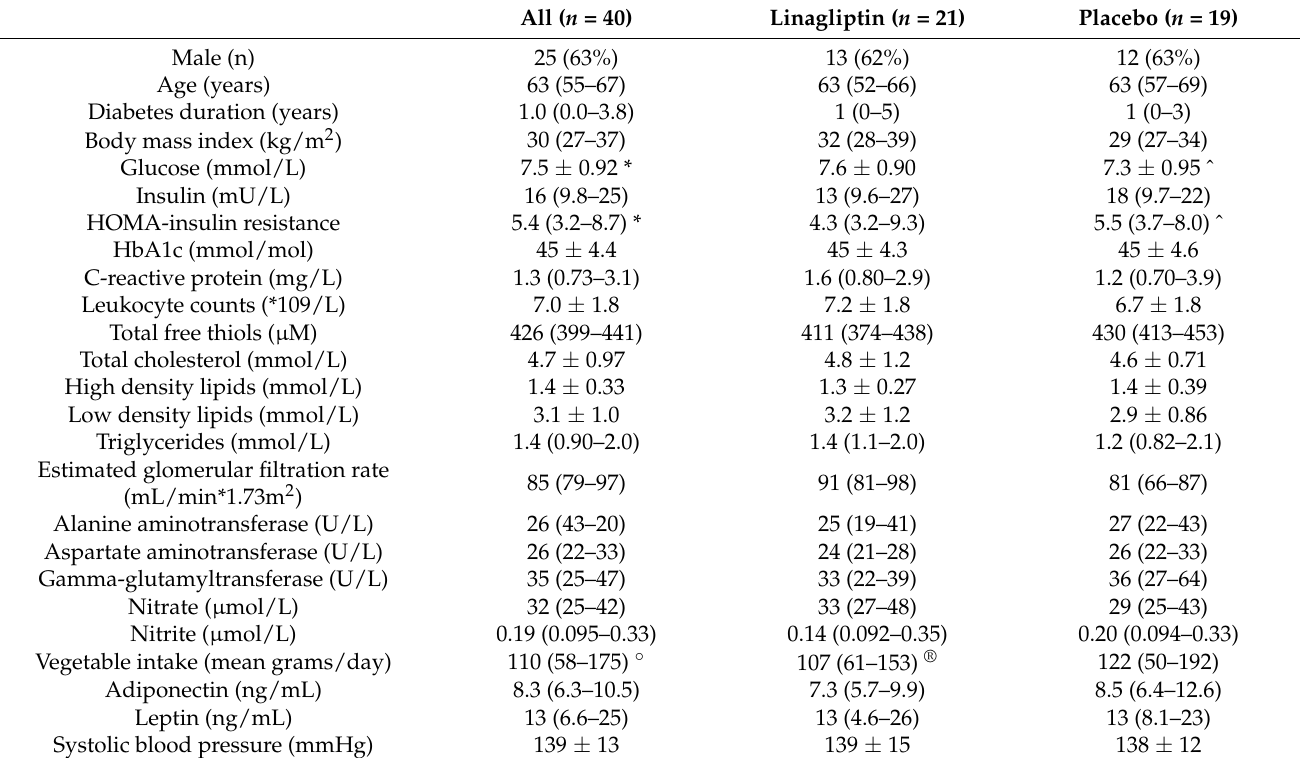
Table 1. Clinical characteristics of the study population at